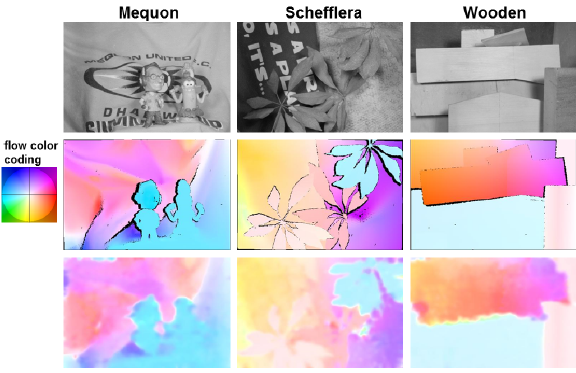
Figure 3: The top row shows the first frame of the input sequences used to our study. The middle row shows the color coded ground truth flow of each image. The bottom row shows the estimated optic flow of our algorithm. In the left-most column we visualize the color coded ground truth flow that indicate speed and direction.